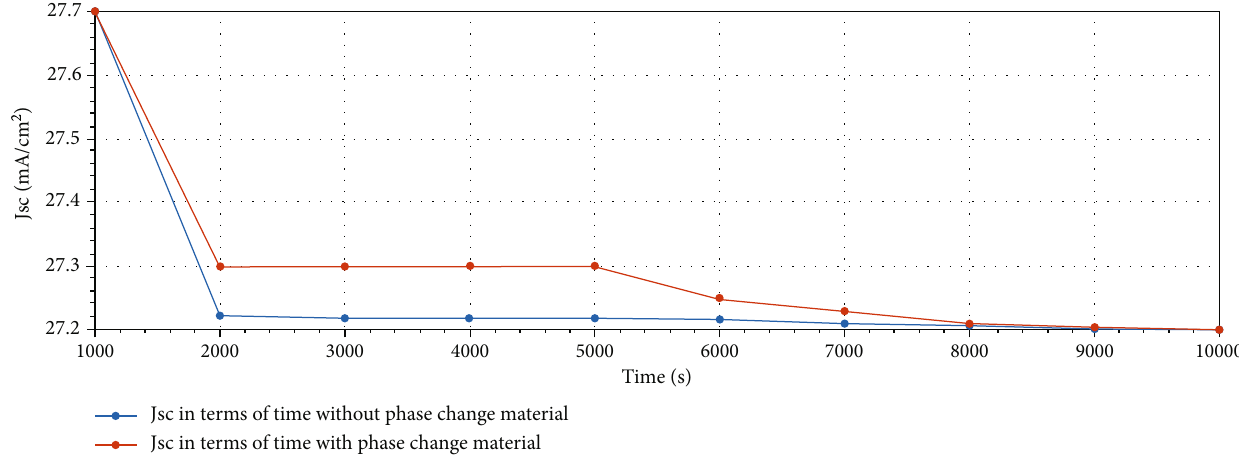
Figure 5: Short-circuit current density in terms of time, assuming a radiation intensity of 1000 watts per square meter in the state with and without the phase change